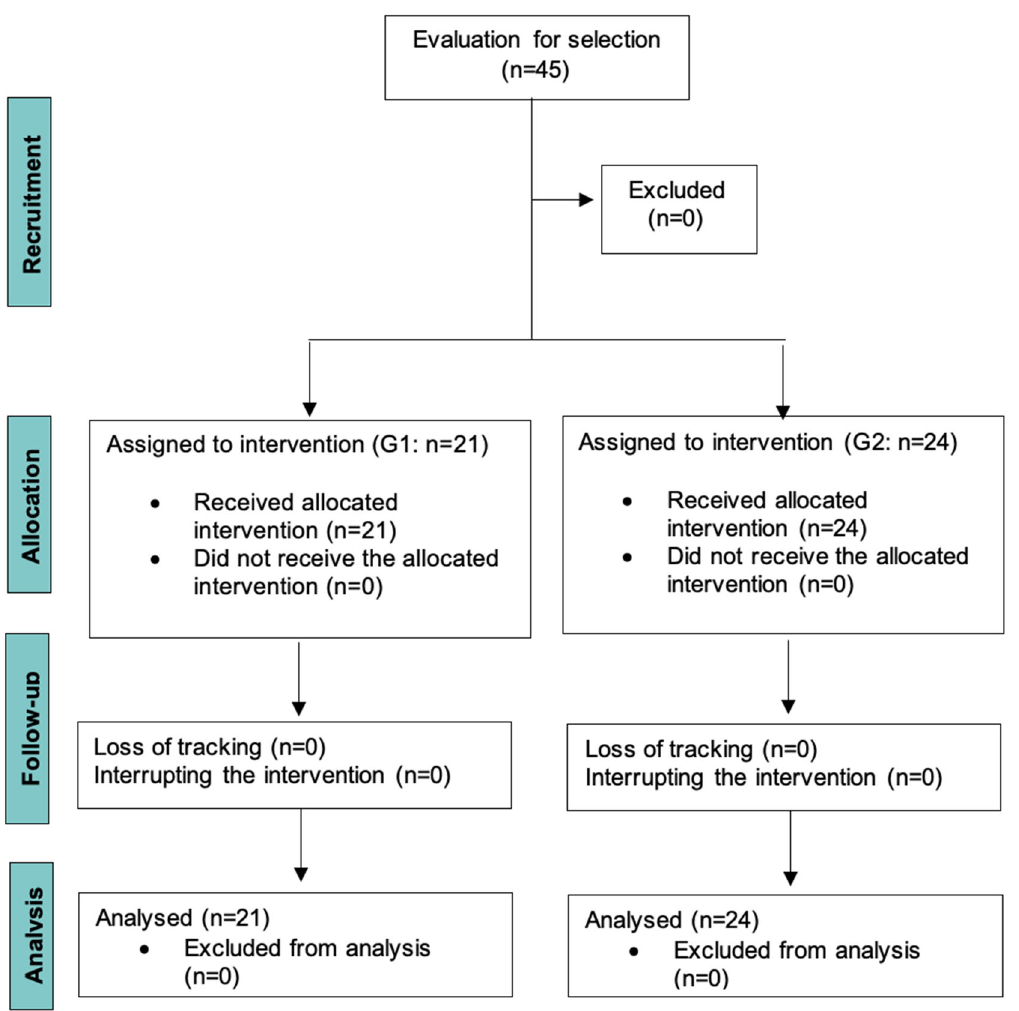
Figure 1. Flowchart of participants included in the study.